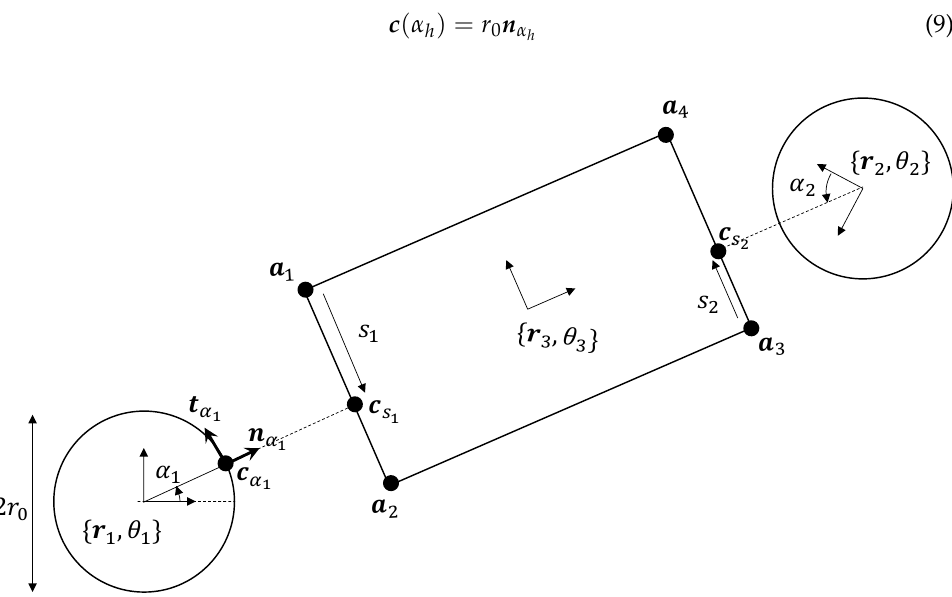
Figure 4. Parameterized surface proxies [25] are virtual points defined as being constrained to be on the surface of objects. By introducing attractive dynamics between these proxies, they can be made to act as the closest points (to the robot hand) on their respective surfaces. In the context of physically interacting objects, the kinematics of such proxies on both surfaces would capture the contact constraints. For instance, with rolling contact between side a 1 a 2 and hand 1, the proxies c α 1 and c s on two rolling bodies would be coincident with no relative velocity. Similarly, the proxies for 1 hand 2 would follow. We define the notation such that, for each point c α on hand h , the closest point h on the object is defined as c s h